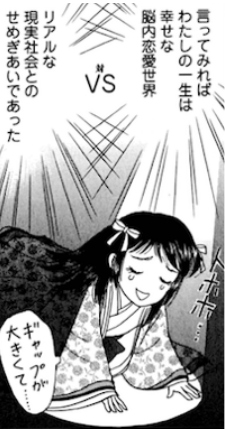
Figure 14. Heroine is torn between romance in her head and real life (Shimizu 2014, 6). Courtesy of Futabasha.